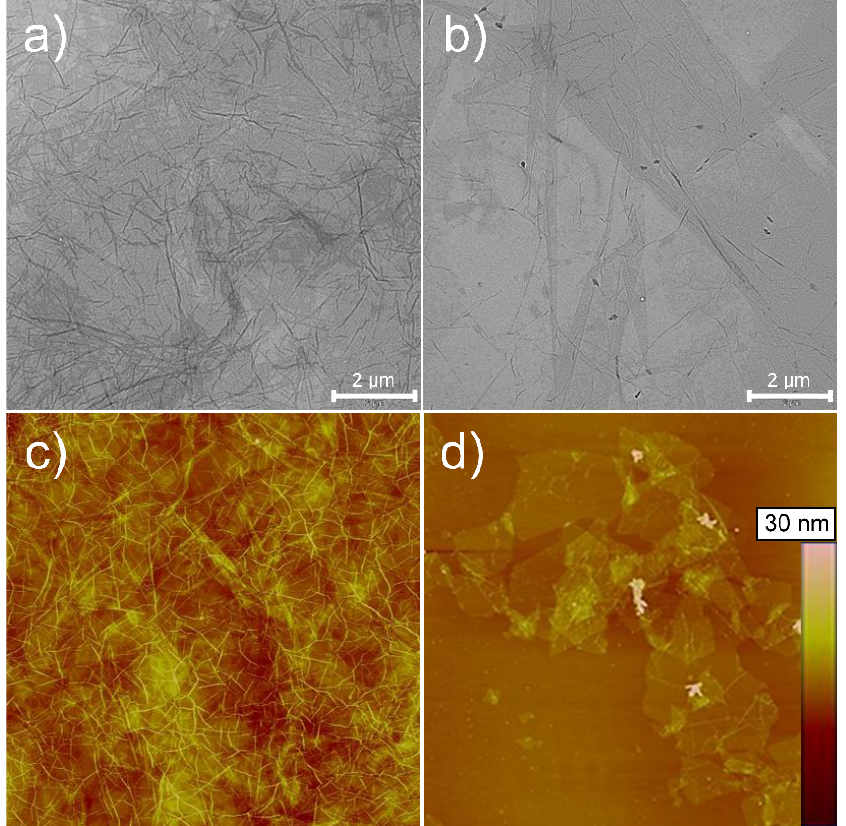
Figure 1. Transmission electron microscopy (TEM) images of graphene oxide (GO) at ( a ) 0.2 wt % and ( b ) 0.02 wt %. Atomic force microscopy (AFM) height images of GO: ( c ) at 0.2 wt % and 15 × 15 µ m 2 ; ( d ) at 0.02 wt % and 40 × 40 µ m 2 . A highly wizened morphology is observed in panels (a) and (c), whereas both individual and overlapping sheets of GO are clearly visible in panels (b) and (d).